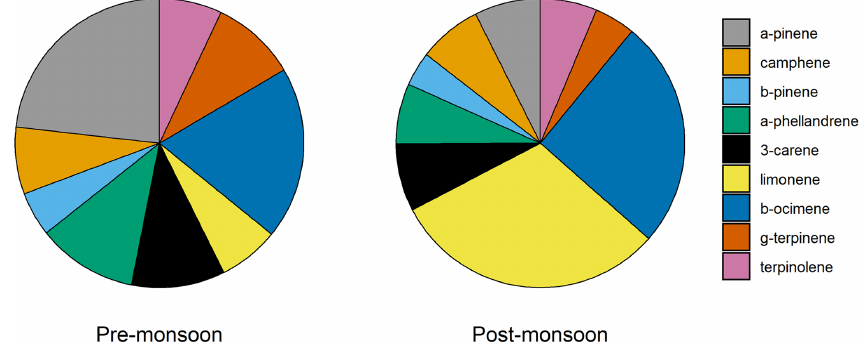
Figure 4. Average composition of monoterpenes across the pre-monsoon and post-monsoon periods.